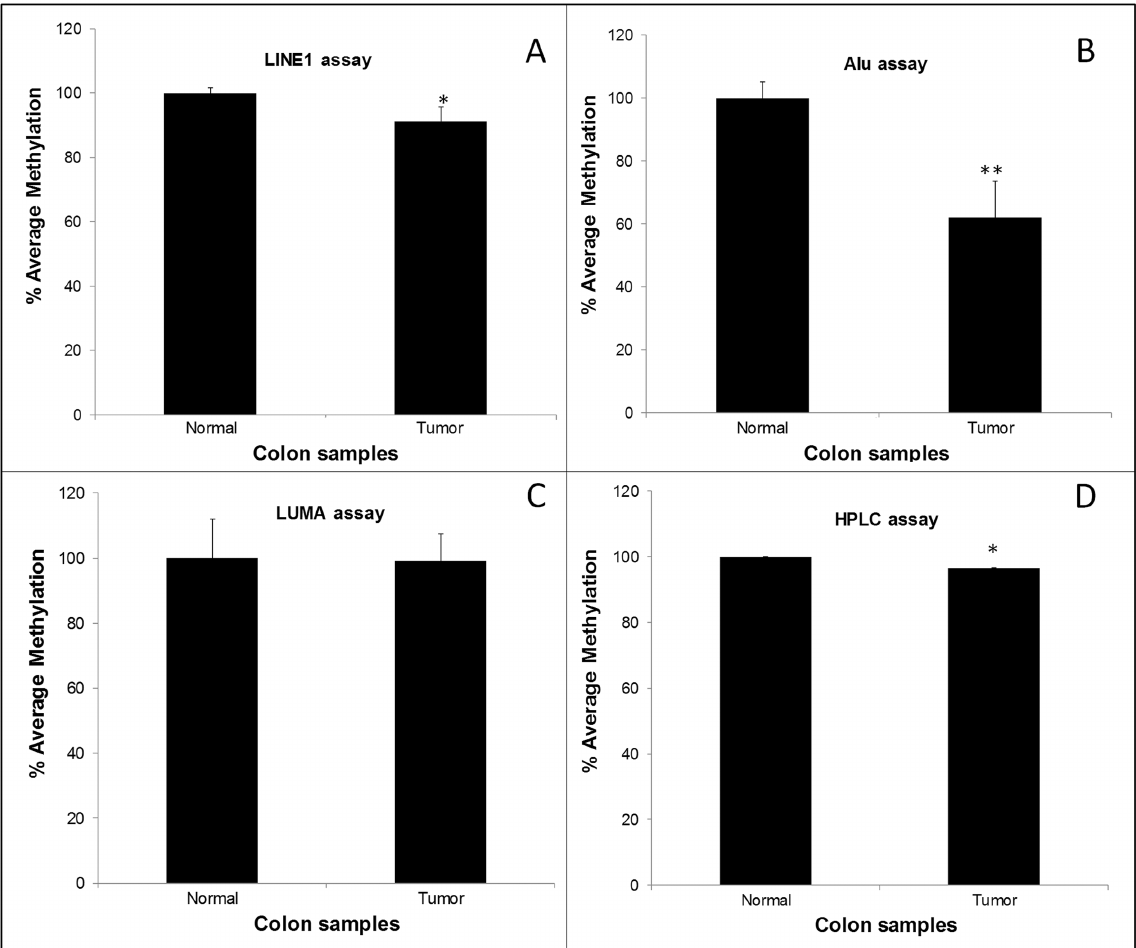
Figure 2. Methylation levels in tumor samples and in matched biopsies of normal colorectal mucosa . As assessed by: A) the LINE1 assay (* P =0.013), B) the Alu assay (** P =0.005), C) the LUMA assay, and D) the HPLC method (* P # 0.029). Data are presented as the mean % of methylation (n=10) relative to the control (i.e. normal colon biopsies). Error bars represent standard deviations.